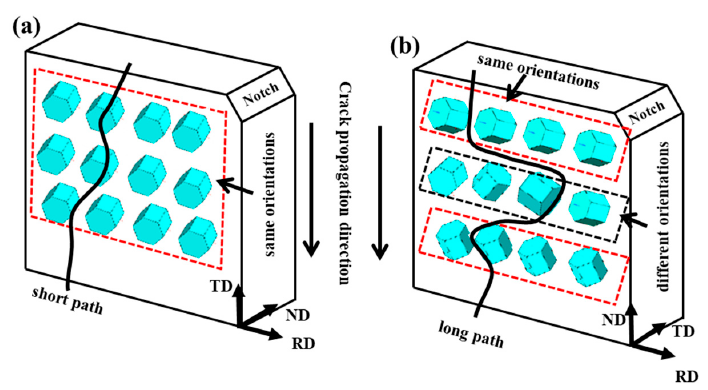
Figure 13. Schematic of the orientation of the α phase at different fracture specimens: ( a ) RD-TD specimen; ( b ) RD-ND specimen.